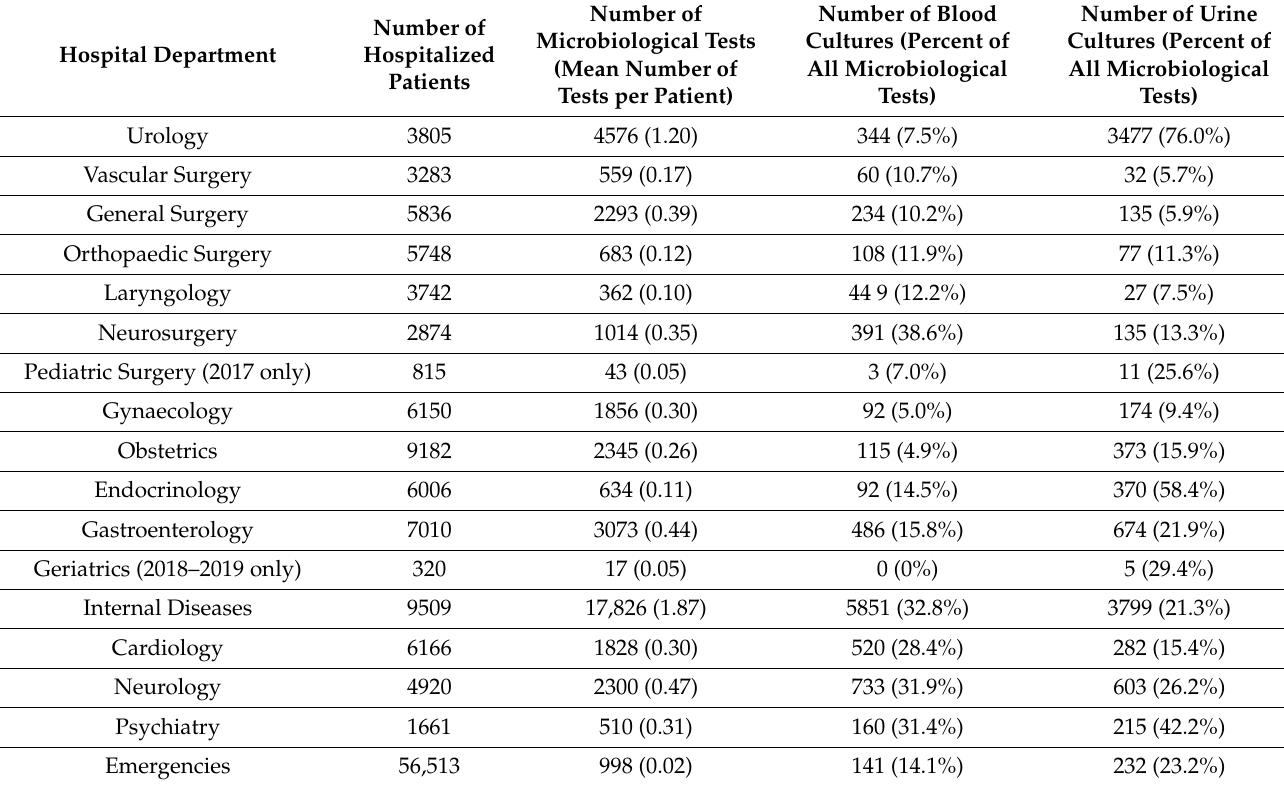
Table 1. Number of hospitalized patients and number of performed microbiological tests, including blood and urine tests in years 2017–2019 depending on department medical